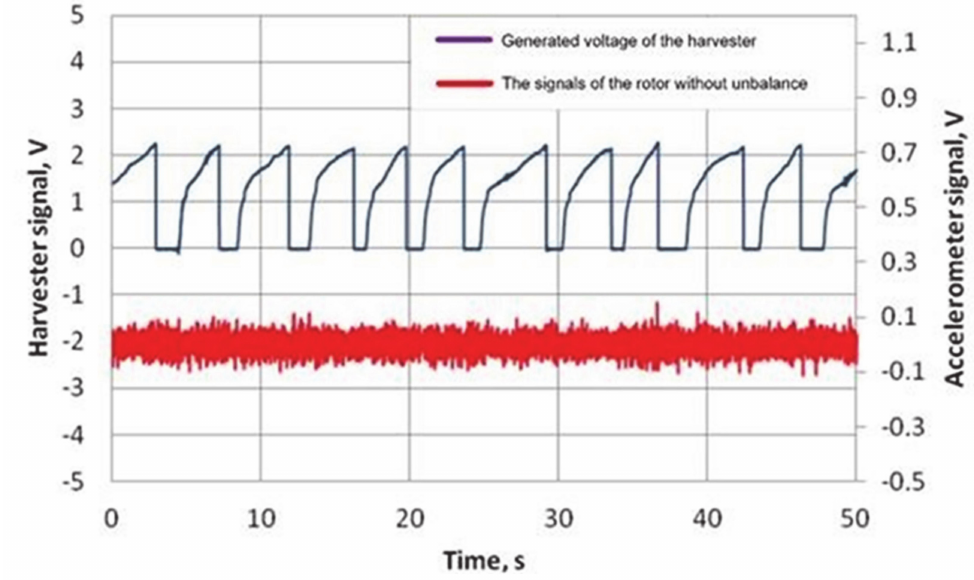
Figure 20. Generated voltage of the harvester (upper blue color) and the signals of the rotor without unbalance (lower red color); the time of capacitor charge until 2 V was ~6 s.